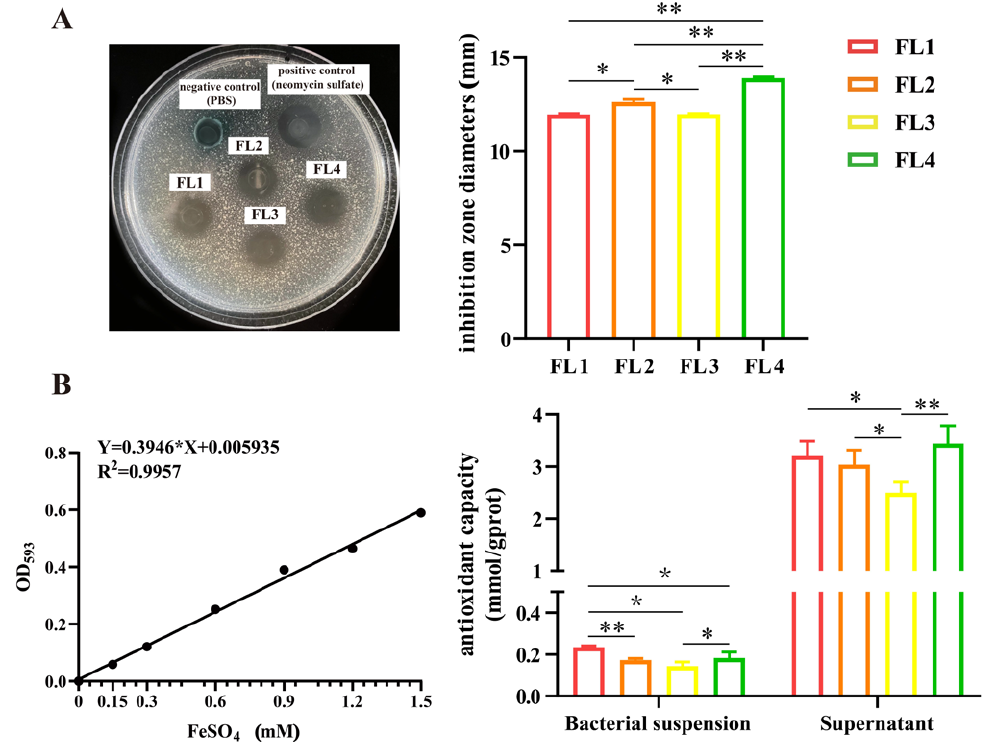
Figure 3. The antimicrobial and anti-oxidation ability of L. fermentum strains. ( A ) The zone of inhibition of L. fermentum against ETEC K88. ( B ) The standard curve of FeSO 4 and the antioxidant capacity of L. fermentum , including its supernatant and bacterial suspension. * p < 0.05, ** p < 0.01.